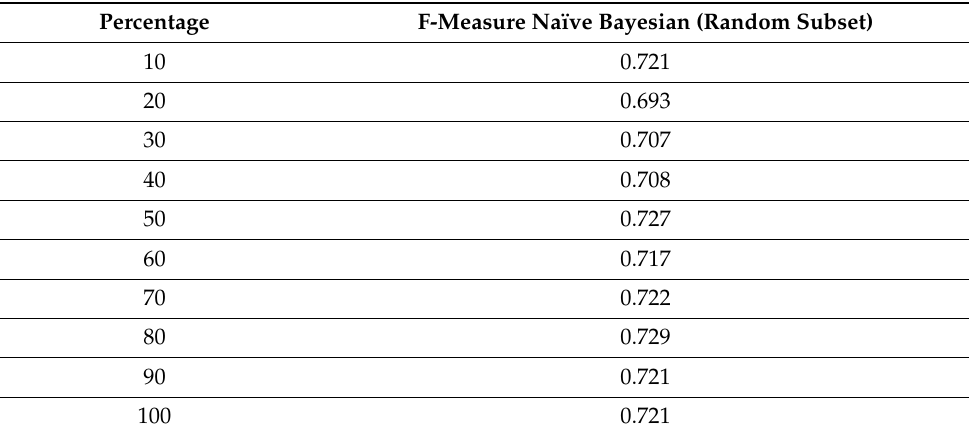
Table 2. F-measure for Naïve Bayesian with a random